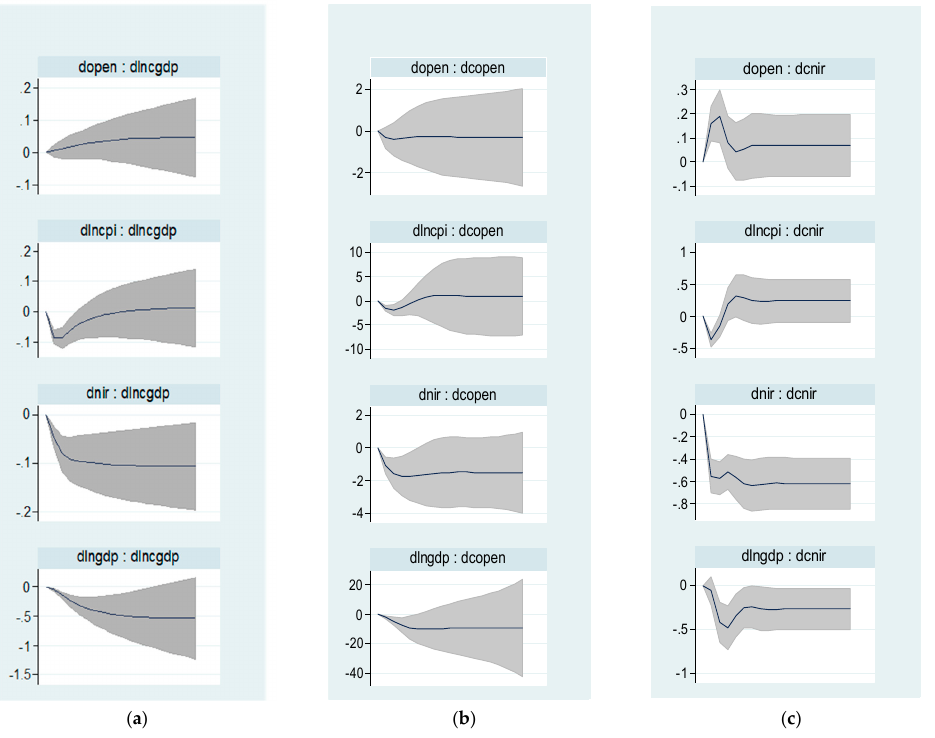
Figure 4. Impulse-Response Functions to BRI’s macroeconomic shocks. Note: Plots are 95% confidence interval with cumulative orthogonalised IRF. It can be seen as an impulse response. ( a ) Response of China—GDP. ( b ) Response of China—Trade. ( c ) Response of China—Interest Rate.